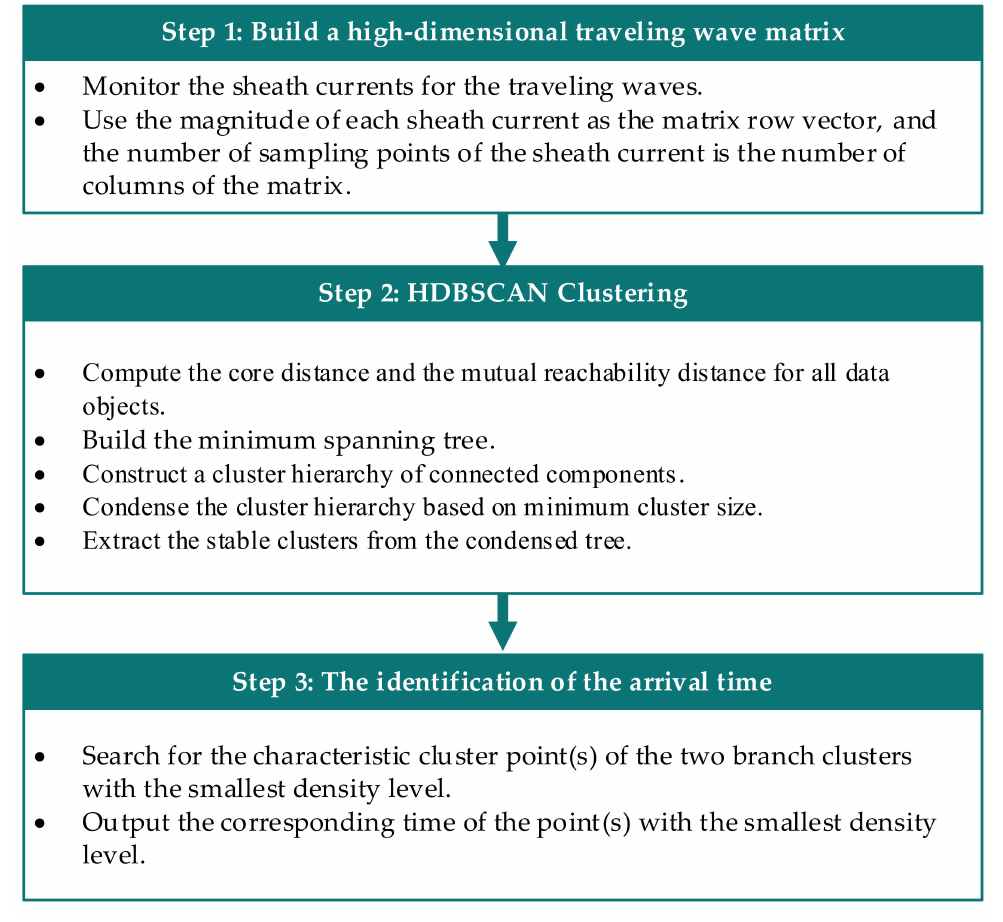
Figure 3. The process of the identification of the arrival time at the two terminals of the